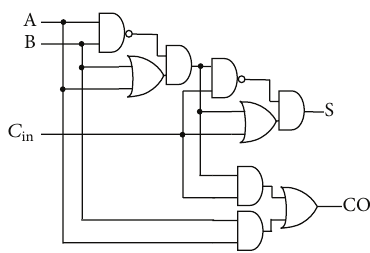
for the accumulator input to have the proper sign for the stored value. The first output of the filter is added by the initial value during the first clock cycle and it is right-shifted and added with the second output in the second clock cycle. This process continues up to the 𝑁 th clock cycle till the final multiplier tap’s value of filter structure is added with previously right-shifted value.